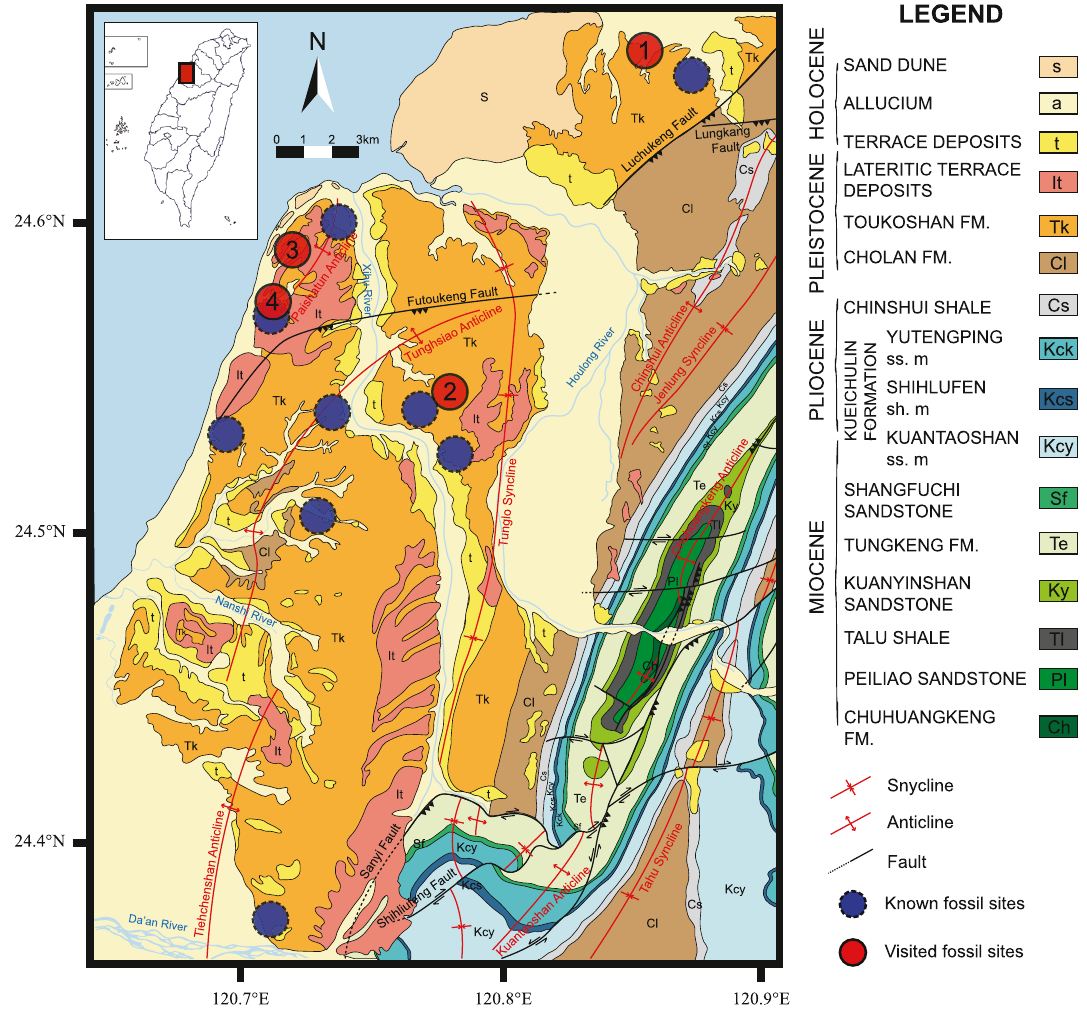
Figure 2. Geologic map and legends of stratigraphic units and major structures of studied area are generated based on 1:50,000 geologic maps (Paishatun, Miaoli, Tachia, and Tungshih) released by the Central Geological Survey of Taiwan with additions of fossil localities. Studied specimens are a subset of museum specimens deposited at the Department of Geosciences, National Taiwan University (NTUG) (Ref. 5 ). Map was created with Adobe illustrator CS6 (https:// www. adobe. com/ produ cts/ illus trator.